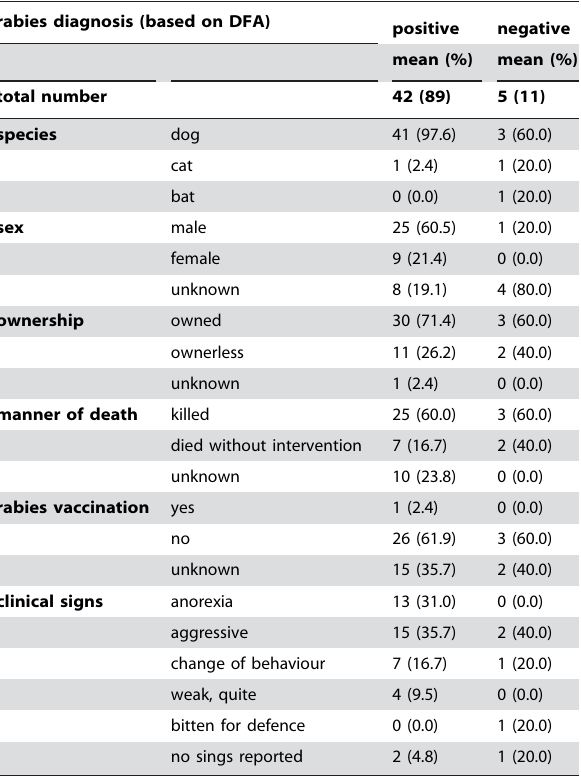
Table 4. Retesting of dRIT and DFA in Chad: Simple Cohen’s kappa coefficients calculated by comparing the retesting results with the DFA result of the samples in fresh condition